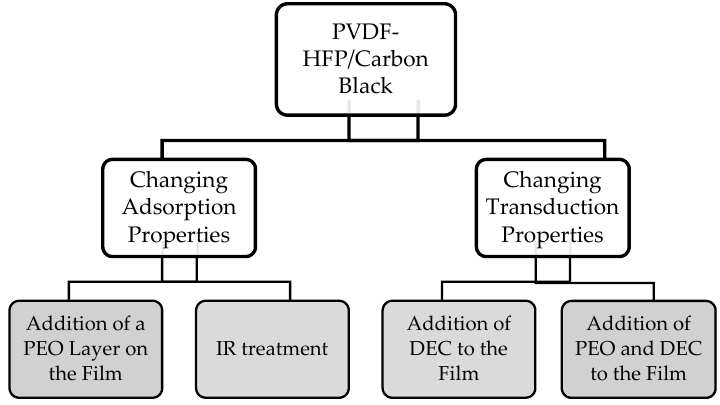
Figure 1. Presented methods to enhance cross selectivity of the porous thin PVDF-HFP/CB film.